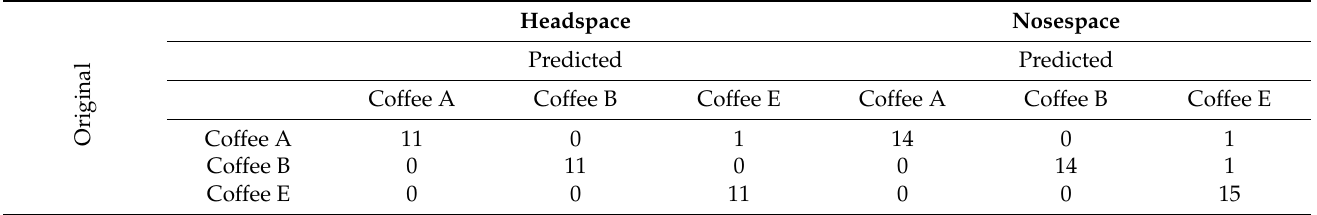
Table 1. Confusion matrices generated by PLS-DA (leave-group-out cross-validation). Models based on headspace and nosespace data are presented (left and right,